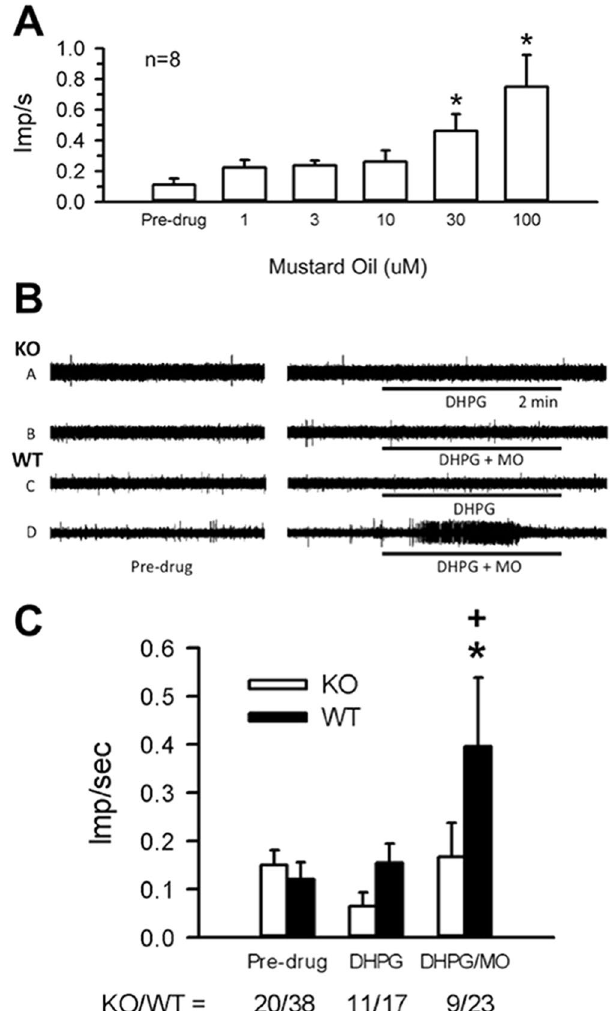
Figure 2. mGluR sensitization of Mechanical Responses in Nociceptors from AKAP WT and KO mice. ( A ) Discharge rates of receptive fields of WT nociceptors following mustard oil (MO) application in ascending doses (2 minutes each). * p < 0.05 vs. pre-drug baseline, Kruskal-Wallis ANOVA on Ranks with Dunn’s posthoc analysis. ( B ) Representative traces from ( A , B ) AKAP WT and ( C , D ) KO nociceptor nociceptor field activity in response to 10 µ M DHPG ( A , C ) alone or ( B , D ) applied with 10 µ M MO. ( C ). Collective drug-induced activity discharge rates of receptive fields from experiments conducted in panel B. * p < 0.05, significant vs. pre-drug; + p < 0.05; significant vs KO at same dose; Kruskal-Wallis ANOVA on Ranks with Dunn’s posthoc